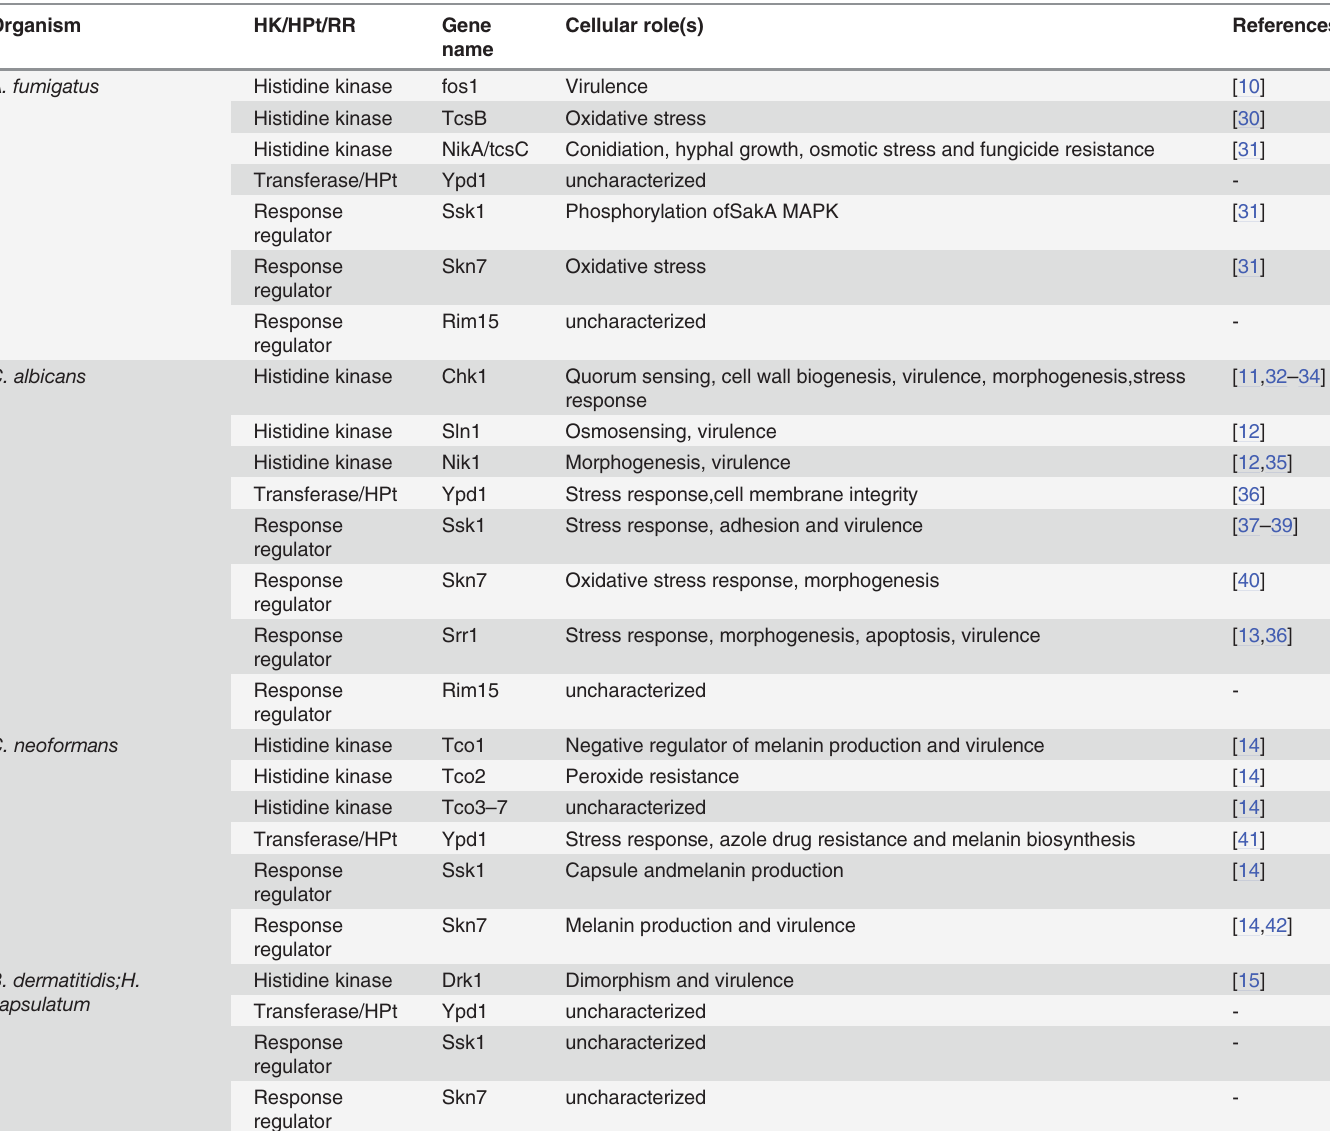
Table 1. List of two-component signaling proteins and their functions in human fungal pathogens.